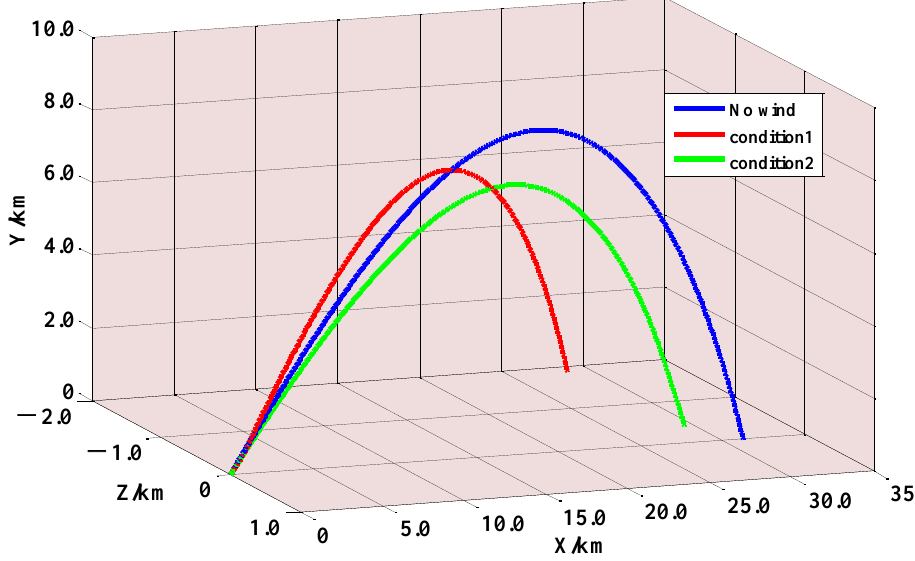
Figure 13. Trajectories of the rocket projectile under different wind field conditions.